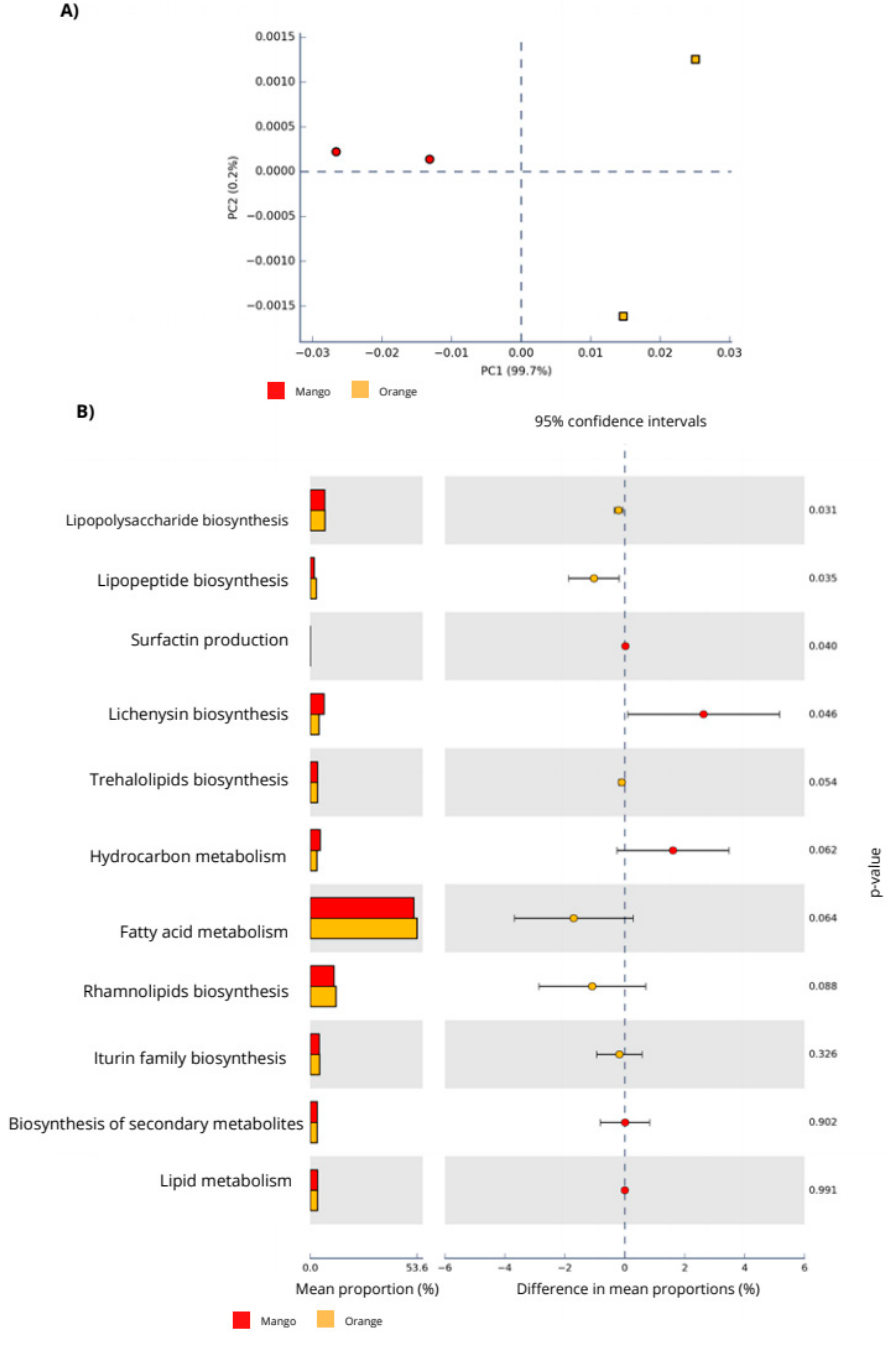
Figure 3. Graphics generated using STAMP software. ( A ) Principal Component Analysis (PCA) between Orange and Mango predicted functional profiles and ( B ) General pathways related to biosurfactant biosynthesis predicted in the microbiota present in enriched Mango and Orange samples.